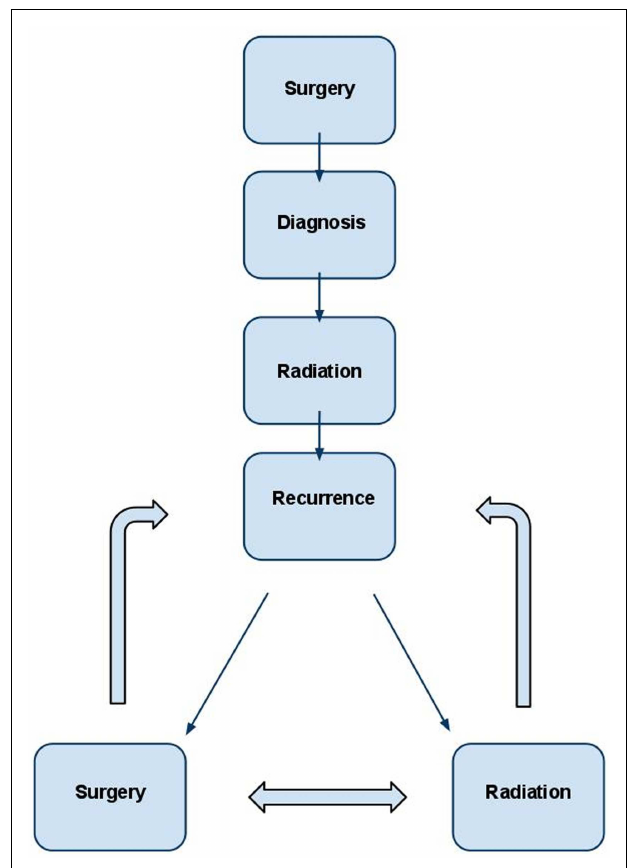
FIGURE 1 | Management strategy forWHO grade II and III meningioma . In the typical patient, diagnosis is first obtained by surgery. Post-operative radiation is administered to decrease the likelihood of recurrence in many cases and almost universally in cases of subtotal resection. If recurrence occurs, retreatment with radiation and/or surgery are both viable options and should be individualized based on the unique clinical scenario.